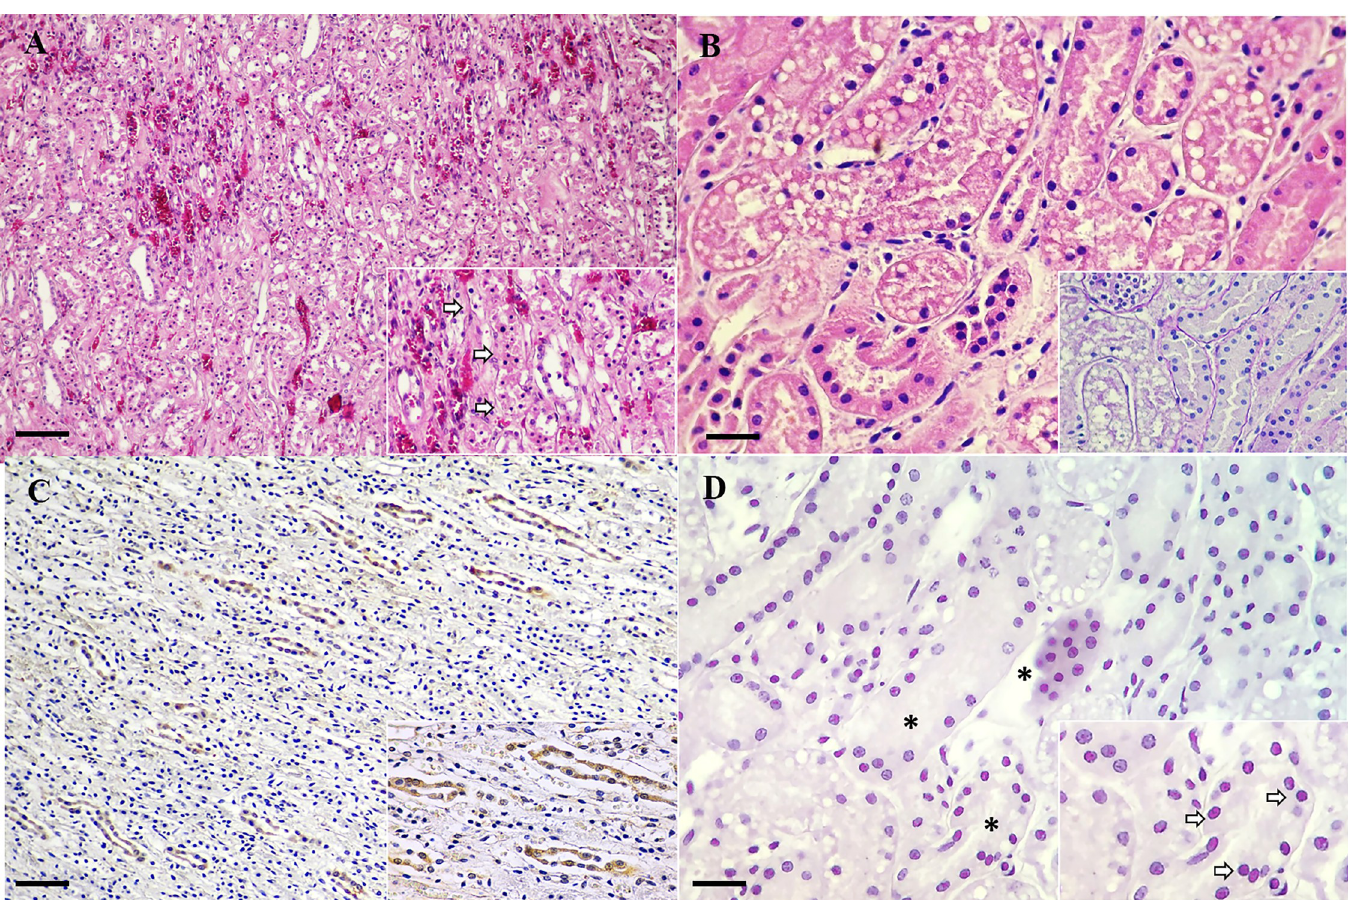
Fig 2. CPPV-1 infection in fishing cats. Demonstrative H&E (A) , PAS staining (B) , CPPV-1 IHC (C) and in situ hybridization (ISH) (D) photomicrographs of kidney from fishing cats. (A, B) Fishing cat no.3. (A) Multifocal renal hemorrhage with renal tubular vacuolation. Few tubular epithelial cells were hypereosinophilic with pyknotic nuclei (inset, arrows). (B) Renal tubular epithelial cells exhibited cytoplasmic vacuole and the nuclei of rare epithelial cells are vesiculate with marginating nuclear chromatin. PAS staining highlighted intact basement membrane (inset). (C) Fishing cat no. 2. CPPV-1 IHC-immunoreactivity (dark-brown color) was diffusely observed in the renal tubules and frequently detected in the cytoplasm of renal tubular epithelium (inset). (D) Fishing cat no.1. CPPV-1 ISH-immunoreactivity (reddish pink color) was abundantly observed in renal tubules (asterisks), and it localized in the nuclei of renal tubular epitheliums (inset, arrows). Bars indicate 50 μ m for (A, C) and 120 μ m for (B,